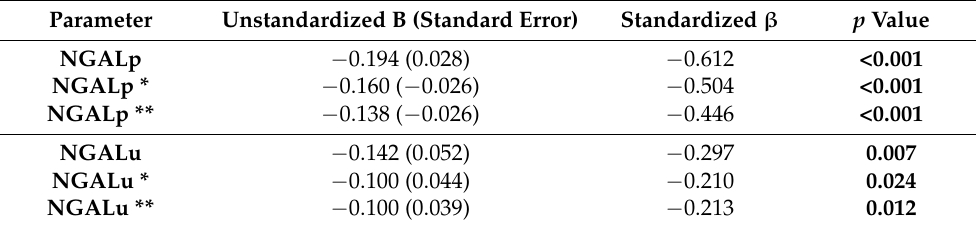
Table 3. Linear regression analysis showing the associations between NGALp, NGALu and eGFR (estimated by CKD EPI formula combining serum creatinine and cystatin C) in patients with T2D (N = 84), adjusting for potential confounders.